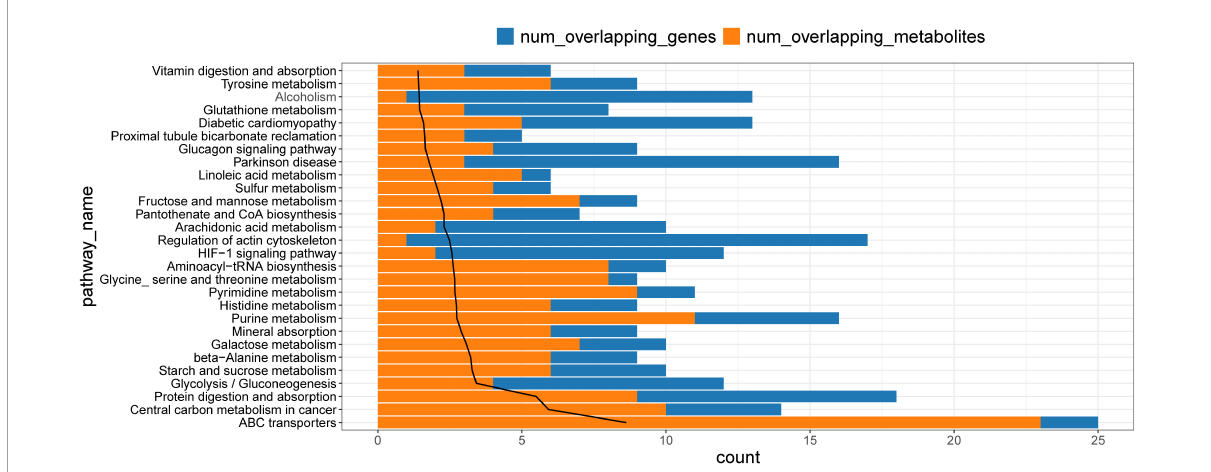
FIGURE6 Kyoto Encyclopedia of Genes and Genomes pathways enriched by differential metabolites and proteins. KEGG, Kyoto Encyclopedia of Genes and Genomes.